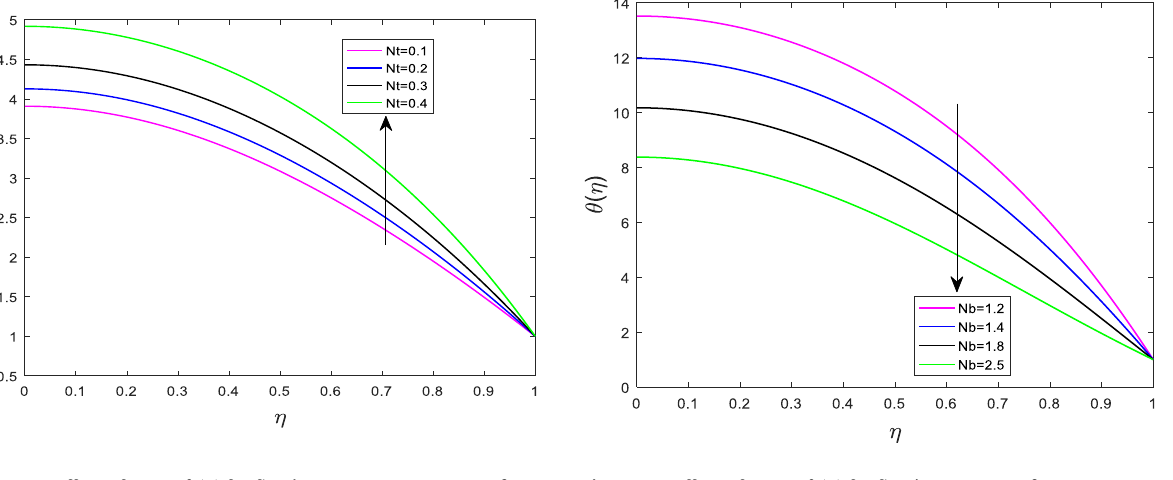
Figure 18: Effect of N t on θ ( η ) for fixed S = Ha = N b = 0.5, β = Ω T = Ω C = 0.1, Ec = 0.1, Pr = 0.7, Kr = 2.0 and Sc = 2.0